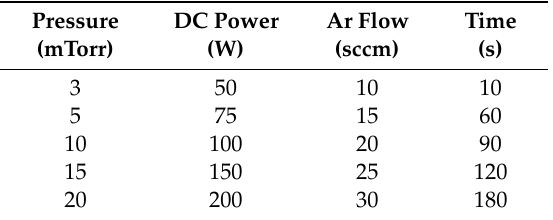
Table 2. Selected values of pulsed-DC reactive magnetron sputtering process’ selected for the optimization of aluminum films using L 25 (4 5 ) orthogonal